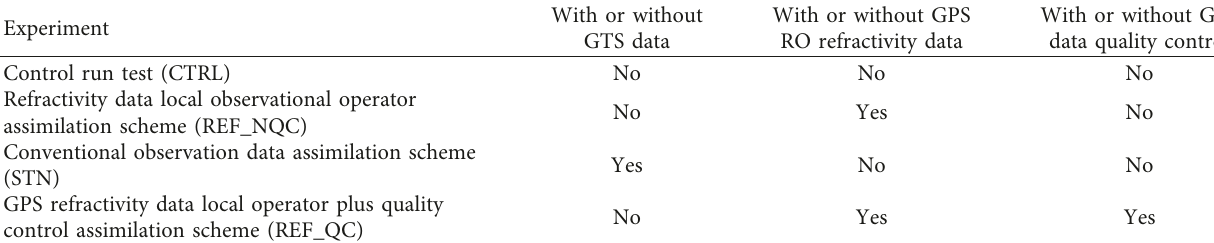
Table 2: Descriptions of the four experiments with their quality control